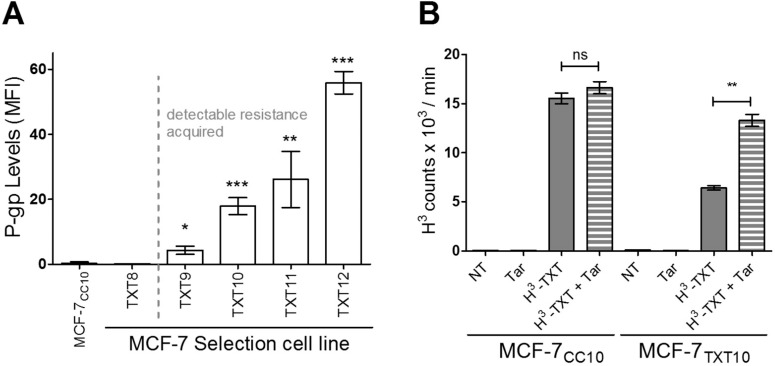
Increased P-gp levels are associated with diminished drug uptake in drug-resistant MCF-7 cells.(A) Flow cytometry was used to assess P-gp levels [as expressed by mean fluorescence intensity (MFI) values] for MCF-7 cells at selection doses 8, 9, 10, 11, and 12. (B) Docetaxel-resistant MCF-7TXT10 cells exhibited decreased intracellular drug accumulation, which was restored with the addition of Tariquidar (Tar), an allosteric inhibitor of P-gp. Tritiated docetaxel (H3-TXT) was administered at a concentration of 2.5 nM, either with or without 100 nM Tariquidar for 12 hours and docetaxel uptake was determined by measuring the radioactivity of cells. All data represents the mean of 3 replicates (+/-SEM). Two-tailed T-tests were employed to assess the significance of differences in docetaxel uptake between the various treatments in the control (MCF-7CC10) and docetaxel-resistant (MCF-7TXT10) cell lines; *** for p<0.0001, **p<0.001, and * for p<0.01.